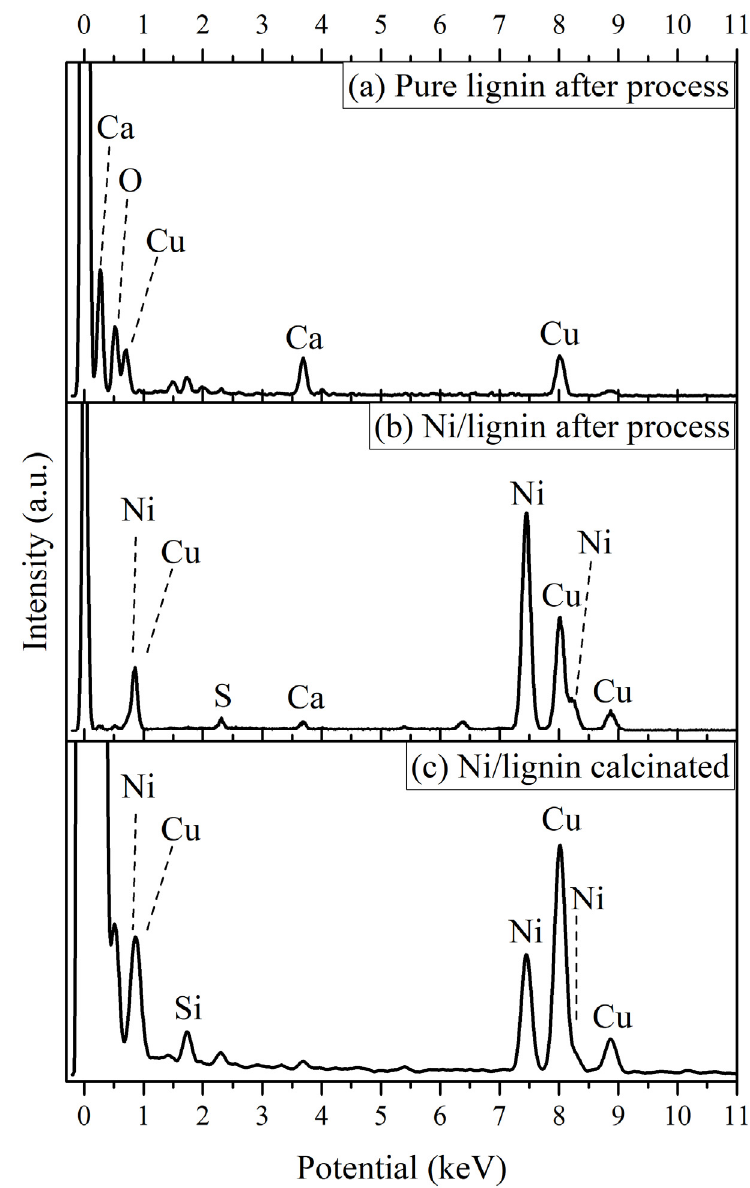
Figure 8. Elemental analysis of images obtained during the study using a transmission electron microscope of the original lignin after the process ( a ), post-process nickel-supported lignin (7 wt. % Ni) ( b ), and lignin coated with nickel compounds after calcination (7 wt. % Ni) ( c ).